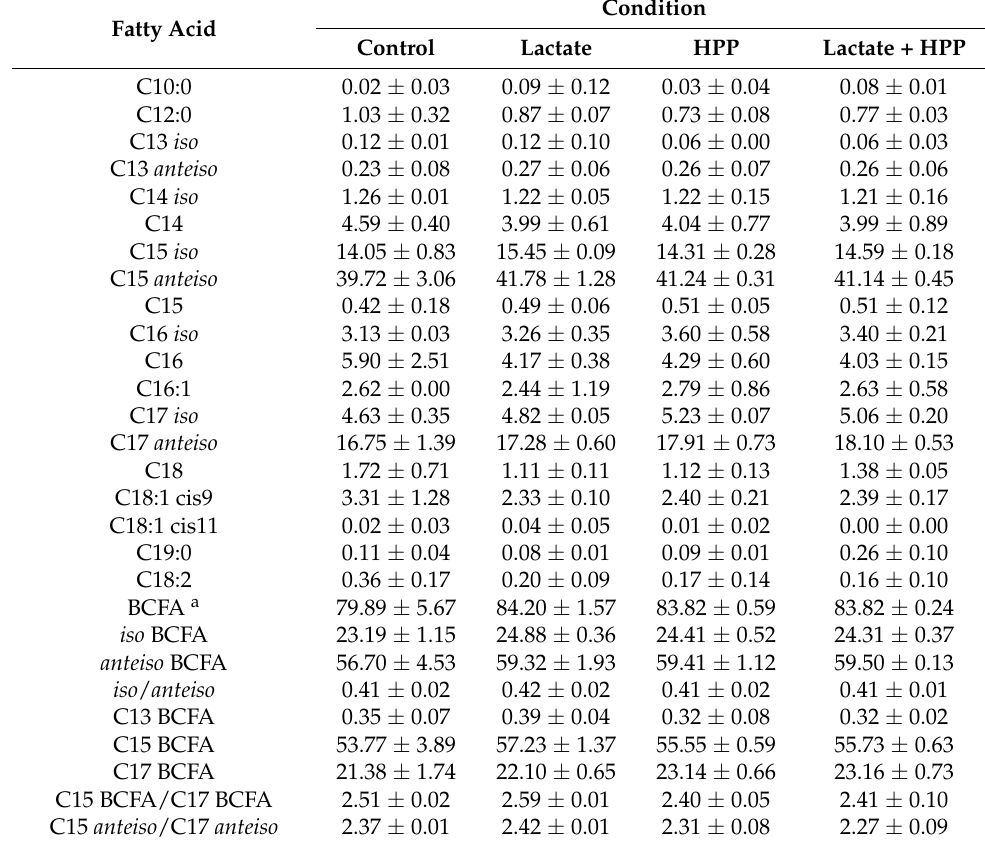
Table 1. Fatty acid profile (mean % ± standard deviation) of L. monocytogenes CTC1034 after exposure of cells to lactate, after the application of the HPP (400 MPa for 10 min), and after the application of both stresses compared to control conditions (exposed to CHMM without